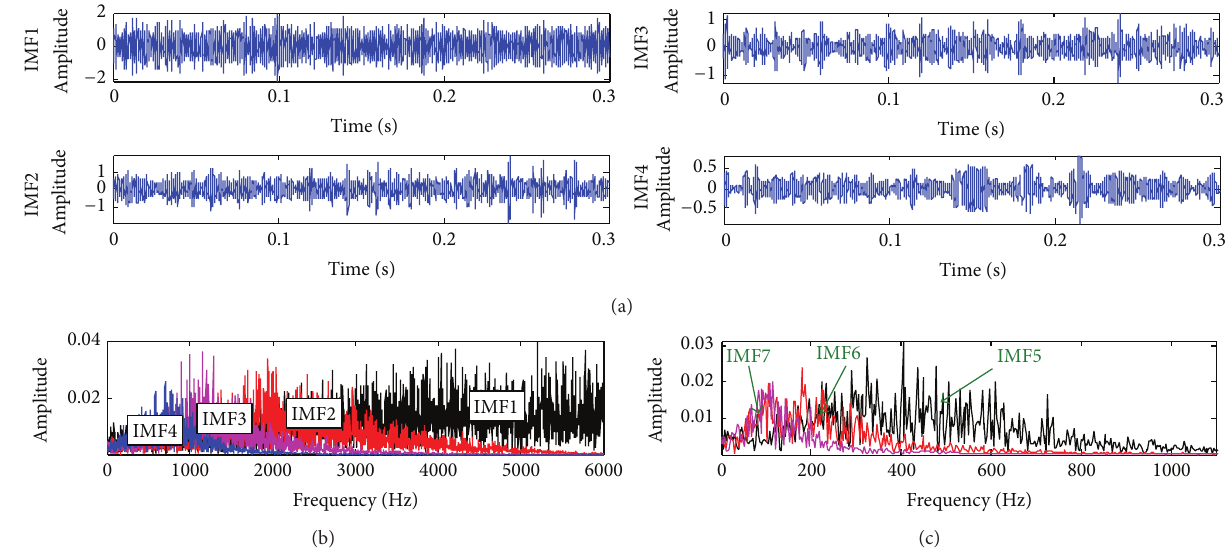
Figure 12: Decomposition results of the simulated signal shown in Figure 8(b) by EMD: (a) waveform of IMF1 ∼ IMF4, (b) power spectrum of IMF1 ∼ IMF4, and (c) power spectrum of IMF5 ∼ IMF7.